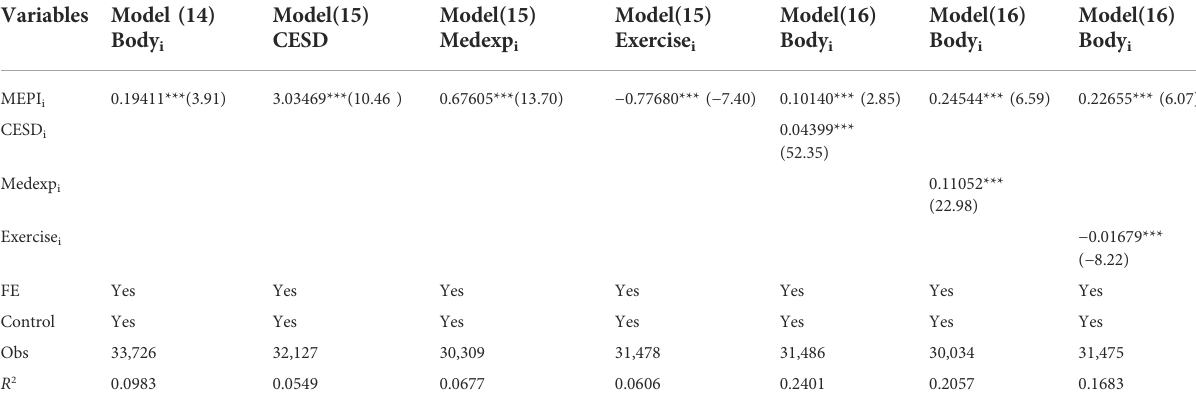
TABLE 8 Mediation effect results regarding physical health.